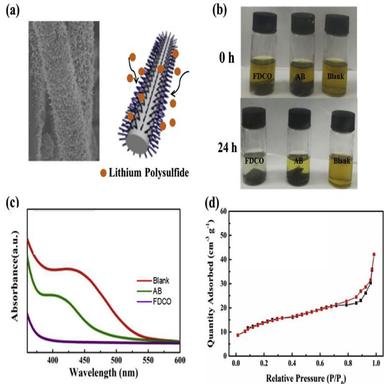
(a) Schematic illustration for the adsorption of polysulfide. (b) and (c) Photographs and UVevis spectra of Li2S6 solution with FDCO and AB. (d) N2 adsorption-desorption isotherm of FDCO.